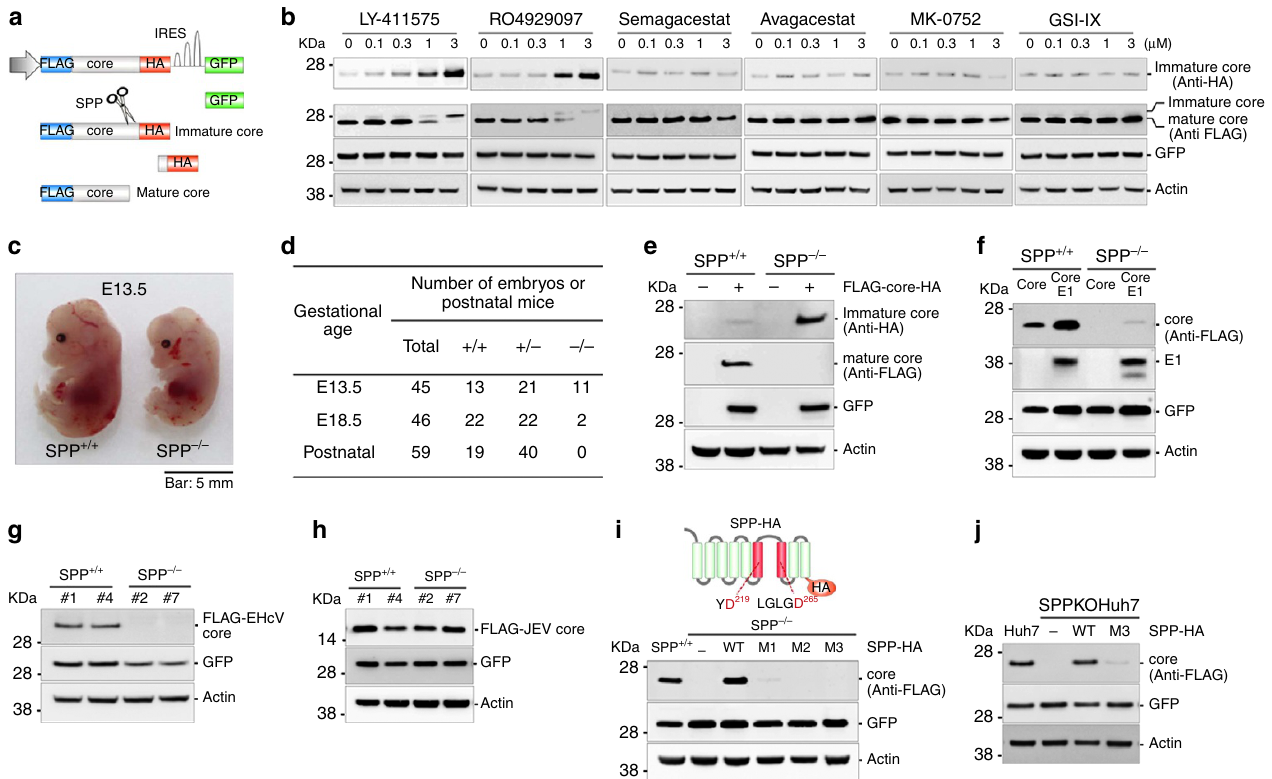
Figure 1 | SPP activity is crucial for the stable expression of mature HCVcore protein. ( a ) Structure of a cDNA clone encoding FLAG-core-HA under the ubiquitin promoter and GFP under the EMCV internal ribosomal entry site (IRES). When processing of the HCVcore protein was inhibited by SPP, staining with anti-HA antibody revealed the immature core protein. ( b ) Huh7 cells expressing FLAG-core-HA were treated with various g -secretase inhibitors at concentrations of 0.1, 0.3, 1.0 or 3 m M for 2 days. ( c ) SPP þ / þ and SPP (cid:2) / (cid:2) embryos at E13.5 arising from SPP heterozygous crosses. Scale bar, 5mm. ( d ) Genotyping of embryos arising from SPP heterozygous crosses. ( e ) The expression levels of FLAG-core-HA in SPP þ / þ and SPP (cid:2) / (cid:2) MEFs at 48h post transfection are shown. ( f ) The expression levels of FLAG-core or FLAG-core-E1 in SPP þ / þ and SPP (cid:2) / (cid:2) MEFs at 48h post transfection are shown. ( g ) cDNAs encoding FLAG-tagged equine hepacivirus core (FLAG-EHcV-core) were introduced into SPP þ / þ (#1 and #4) and SPP (cid:2) / (cid:2) (#2 and #7) MEFs. ( h ) A cDNA encoding FLAG-tagged JEV core (FLAG-JEV core) was introduced into SPP þ / þ (#1 and #4) and SPP (cid:2) / (cid:2) (#2 and #7) MEFs. ( i ) Transmembrane regions 6 and 7 in SPP (indicated in red) encode peptidase activity to cleave substrates (upper). SPP þ / þ and SPP (cid:2) / (cid:2) MEFs stably expressing HA-tagged SPP wild type (WT), SPP-HA D219A (mutant 1; M1), SPP-HA D265A (mutant 2; M2), and SPP-HA D219/265A (mutant 3; M3) were infected with a lentivirus expressing FLAG-core (lower). ( j ) Huh7 and SPPKOHuh7 cells stably expressing SPP-HA (WT) and SPP-HA (M3) were infected with a lentivirus expressing FLAG-core. The data are representative of either three ( b , c ) or two ( e – j ) independent experiments. NATURE COMMUNICATIONS|7:11379|DOI: